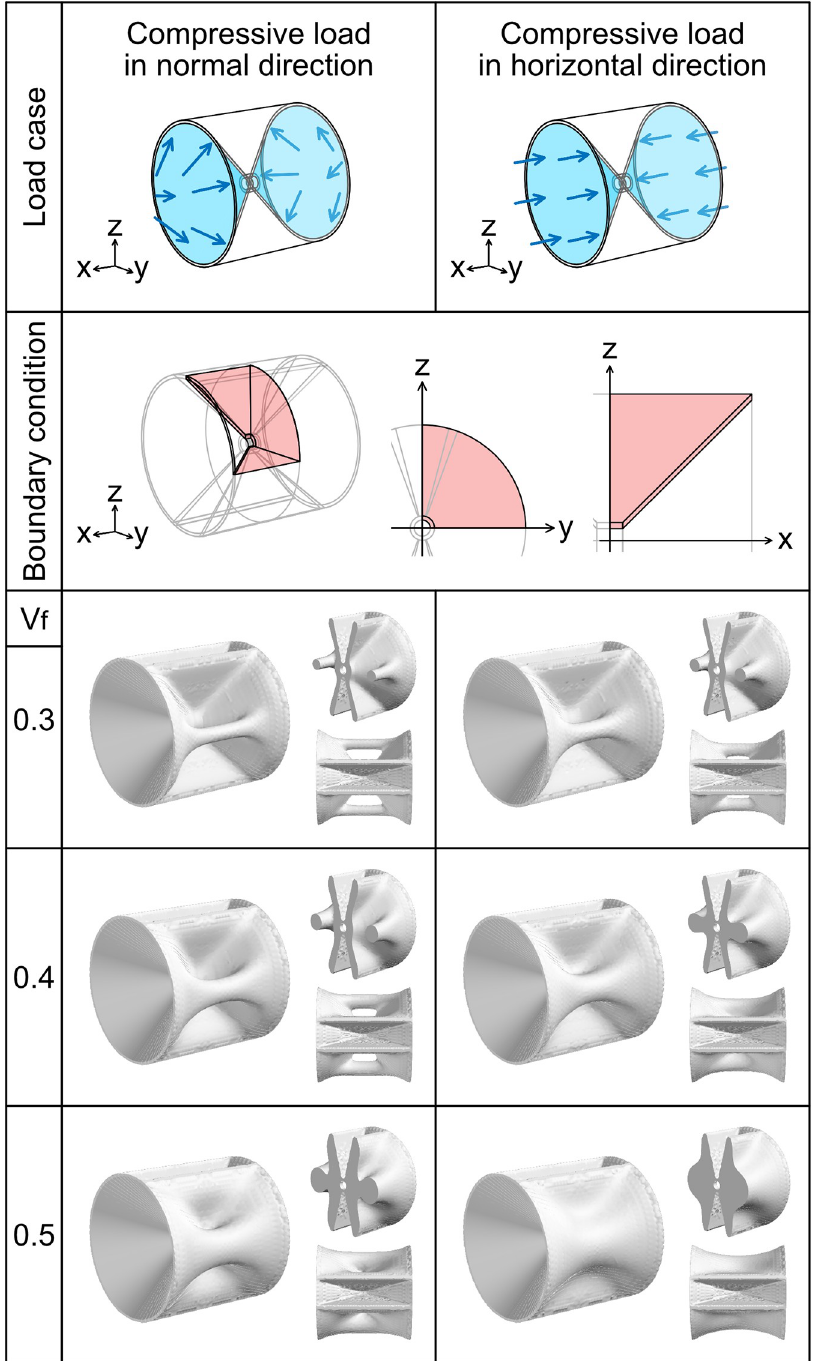
Fig 3. Optimization for compressive loads to autocentrum. The uppermost images are diagrams of the loads. The arrows indicate the load directions. The blue-colored area indicates where the load was applied. The images in the second row from the top show diagrams of the boundary condition; the boundary condition is the same in the two different compressive load cases. We imposed the symmetric boundary condition u � n = 0 to the pink-colored area on the xy, yz, and zx planes and used an eighth model (left). The middle and right images in this row indicate the areas to which the symmetric boundary condition was imposed on the yz and zx plane, respectively. The area of the symmetric boundary condition on the xy plane is similar to that on the zx plane. The images in the third, fourth, fifth rows are the entire structures, transverse sections, and top views of the optimization results. The numbers in the leftmost column show the volume